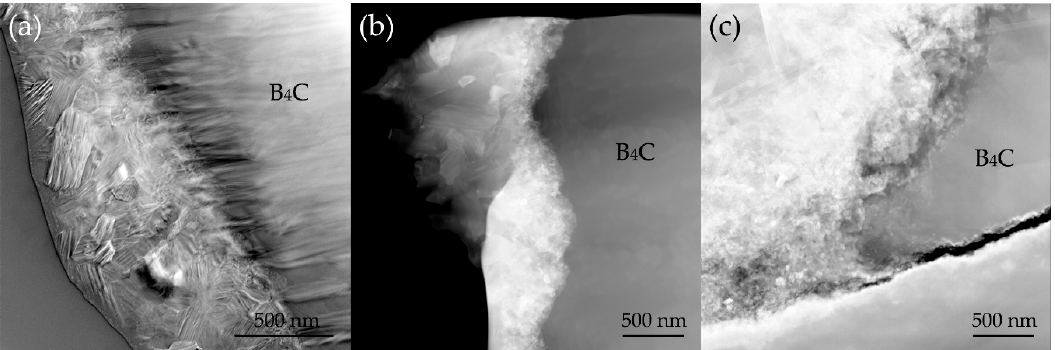
Figure 4. TEM (transmission electron microscopies) images: ( a ) Ti + 30 vol. % B 4 C, ( b ) Ti + 30 vol. % B 4 C + 20 vol. % Ti-Al(1) and ( c ) Ti + 30 vol. % B 4 C + 20 vol. % Ti-Al(2).